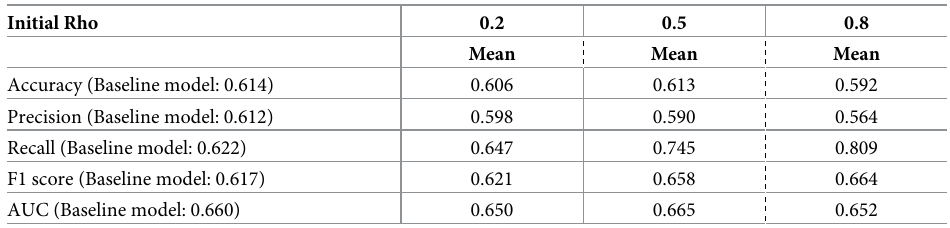
Table 5. Result of the estimation of the SAR model with 500